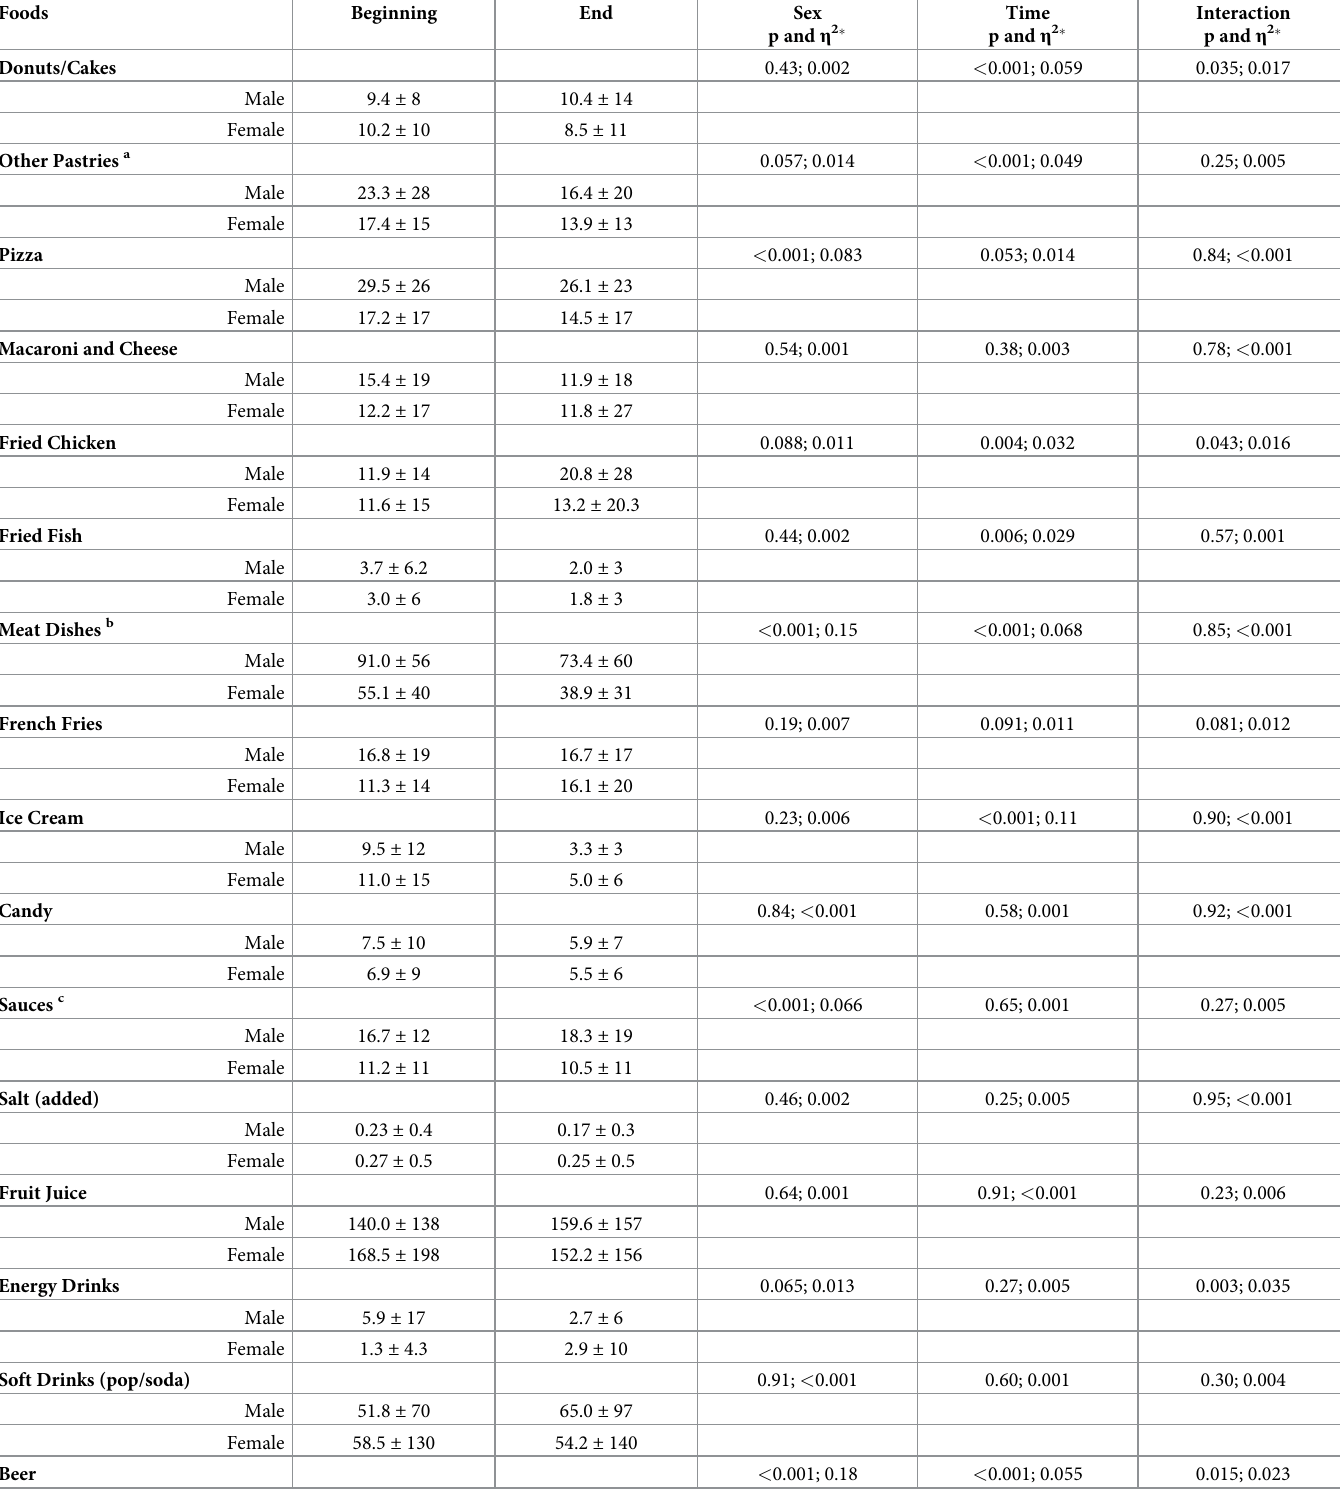
Table 4. Assessing diet quality: Foods that are generally seen as part of an unhealthy diet. Intakes (g/day) are from beginning to end of first-year university in male (n = 50) and female (n = 210) students.